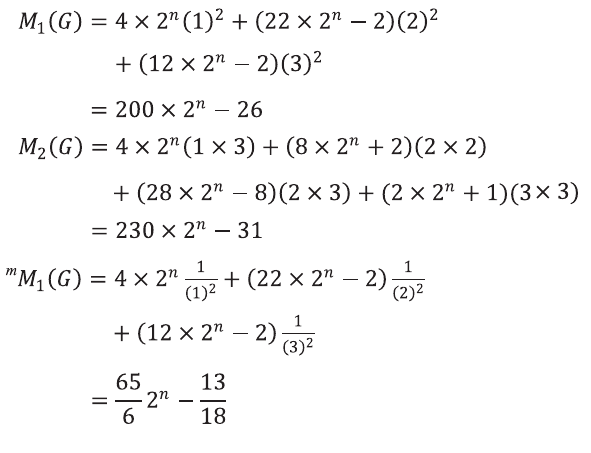
Figure 2: Comparison of degree-based indices.